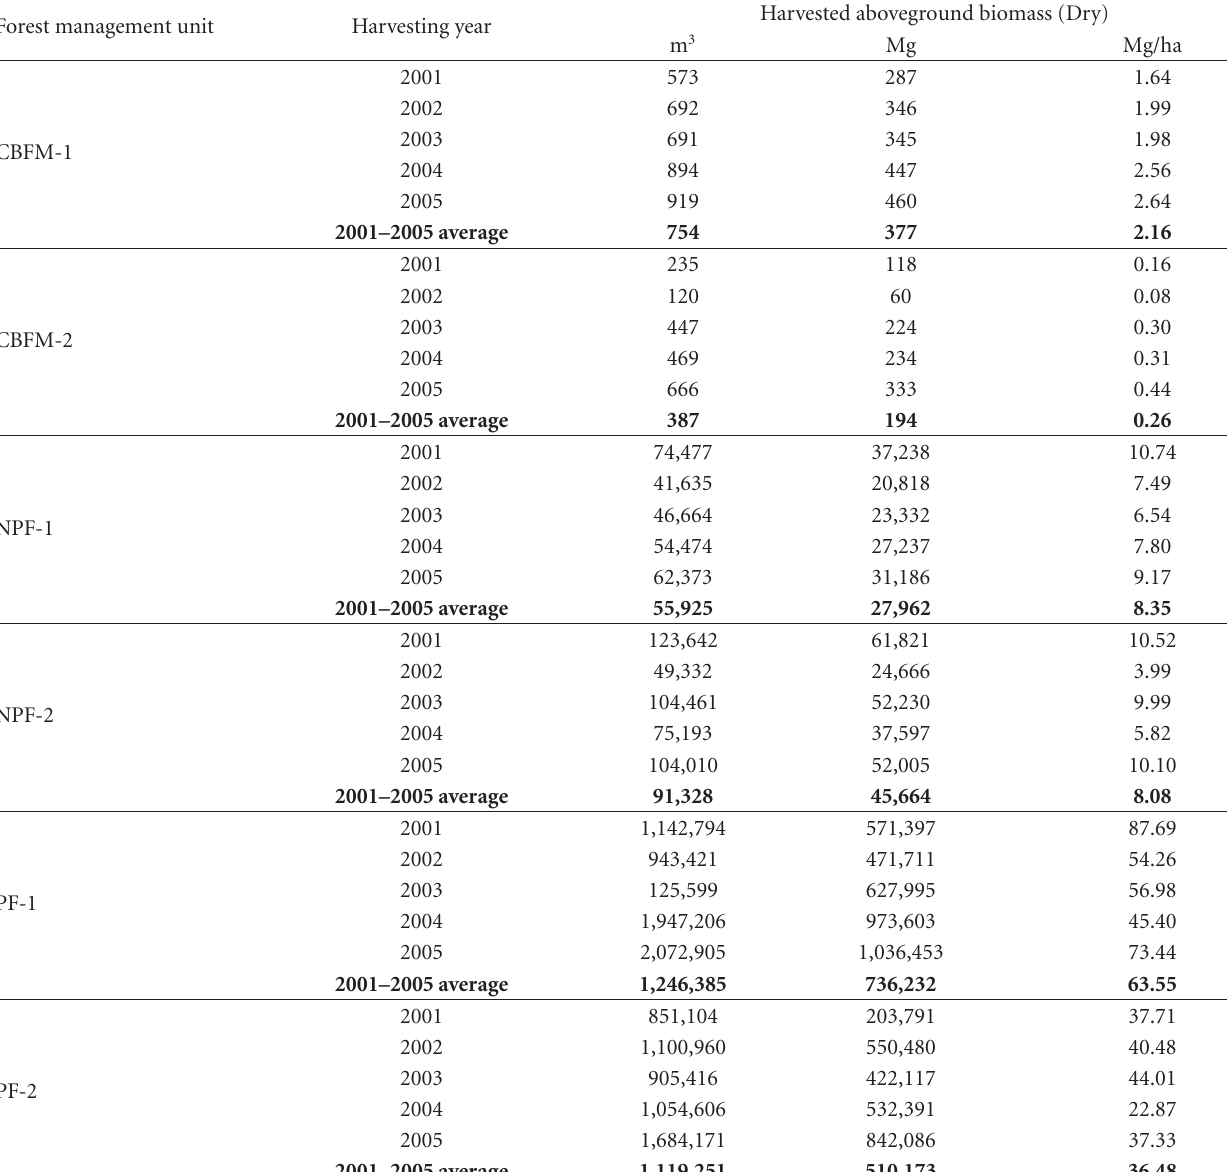
Table 1: Commercial forest biomass harvested from each certified forest management unit between